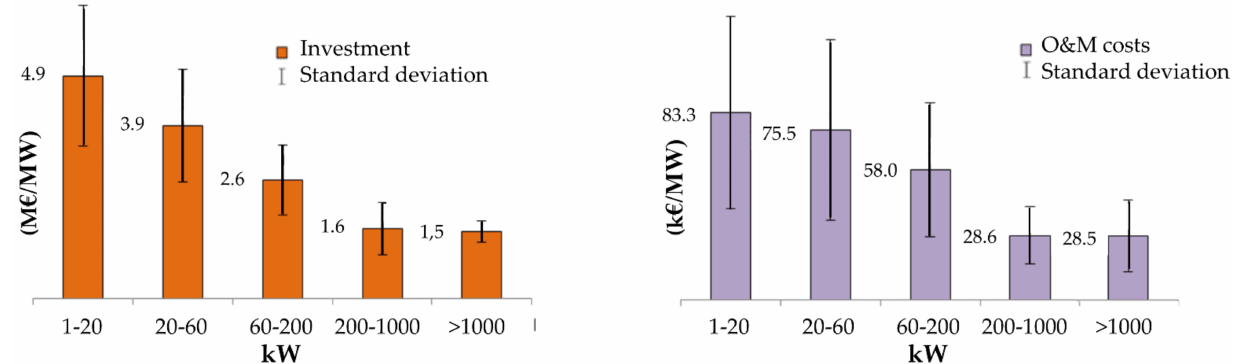
Figure 2. Bar chart of the estimated investment ( left ) and O&M ( right ) costs per MW of an onshore HAWT, according to the class of mean electric power produced. Based on data retrieved from Ref.